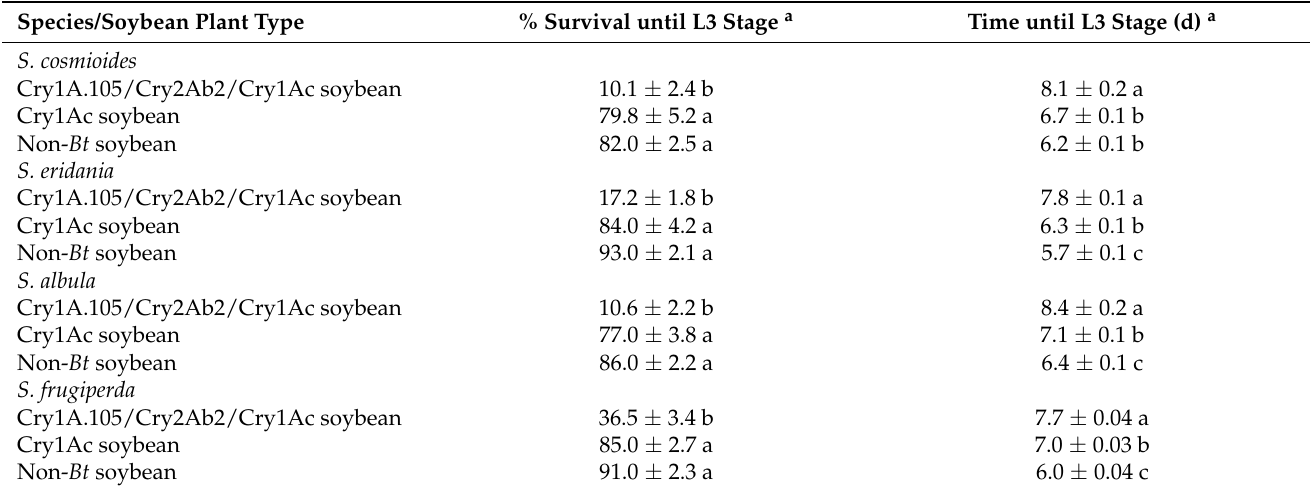
Table 2. Survivorship and developmental time of Spodoptera species on Bt and non- Bt soybean leaves in laboratory